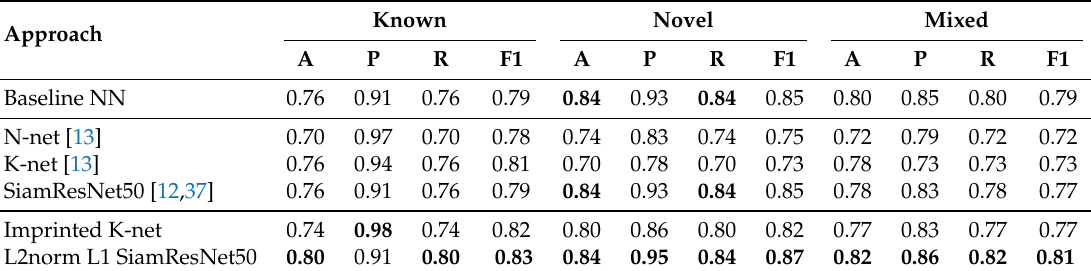
Table 4. Test results obtained on the SNG-20 set, when evaluating on top-1 matches. Measured in terms of Accuracy, Precision, Recall and F1 score. Each test example is provided with a 10-image support set, at inference